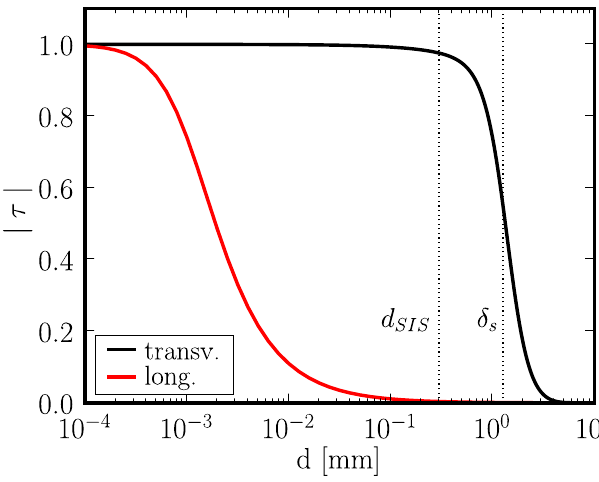
FIG. 3. (Color) Comparison of transverse and longitudinal trans- mission coefficients for SIS 100 parameters vs wall thickness. . The wall thickness and The frequency is chosen as f (cid:2) 0 : 5 f 0 the skin depth are indicated.